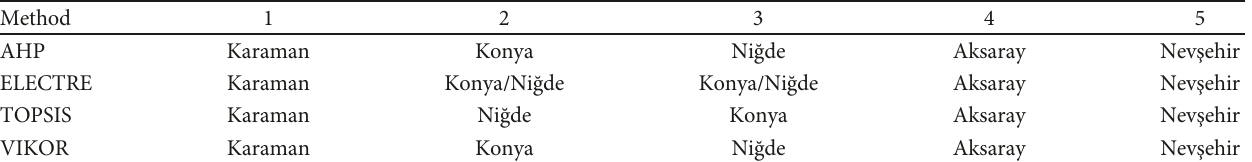
Table 10: Results with AHP, ELECTRE, TOPSIS, and VIKOR